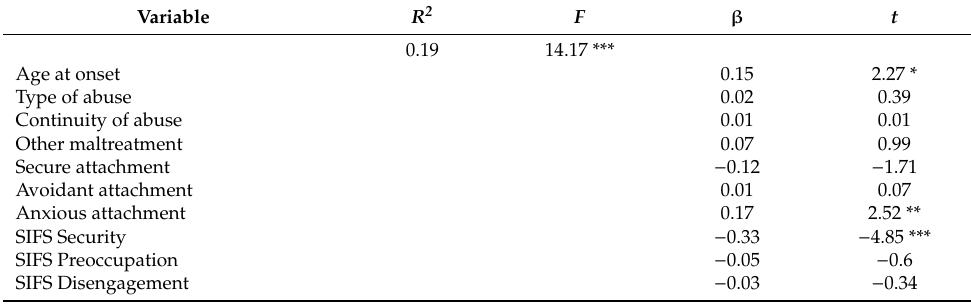
Table 6. Regression analysis of present suicidal ideation as a function of the characteristics of the abuse, existence of other maltreatment, attachment, and security in the family system ( n =